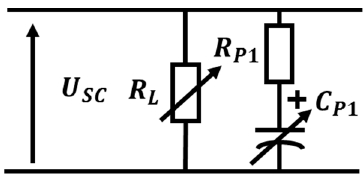
Figure 7. Electrical circuit of redistribution and leakage effects of a SC cell.